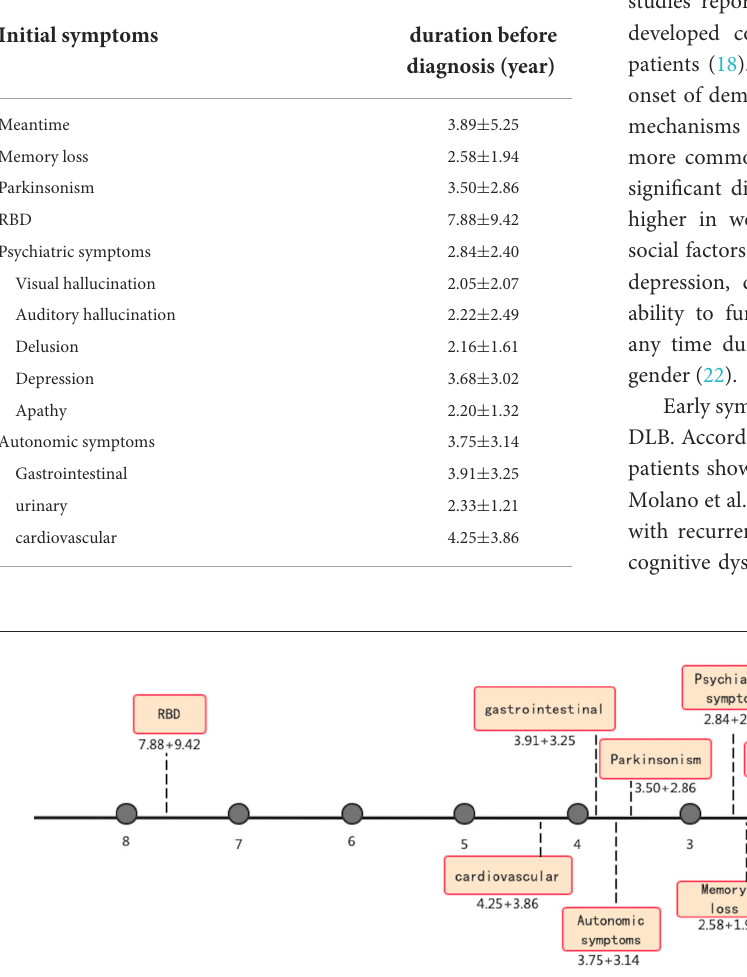
TABLE 1 The duration of initial symptoms before diagnosis in DLB patients.